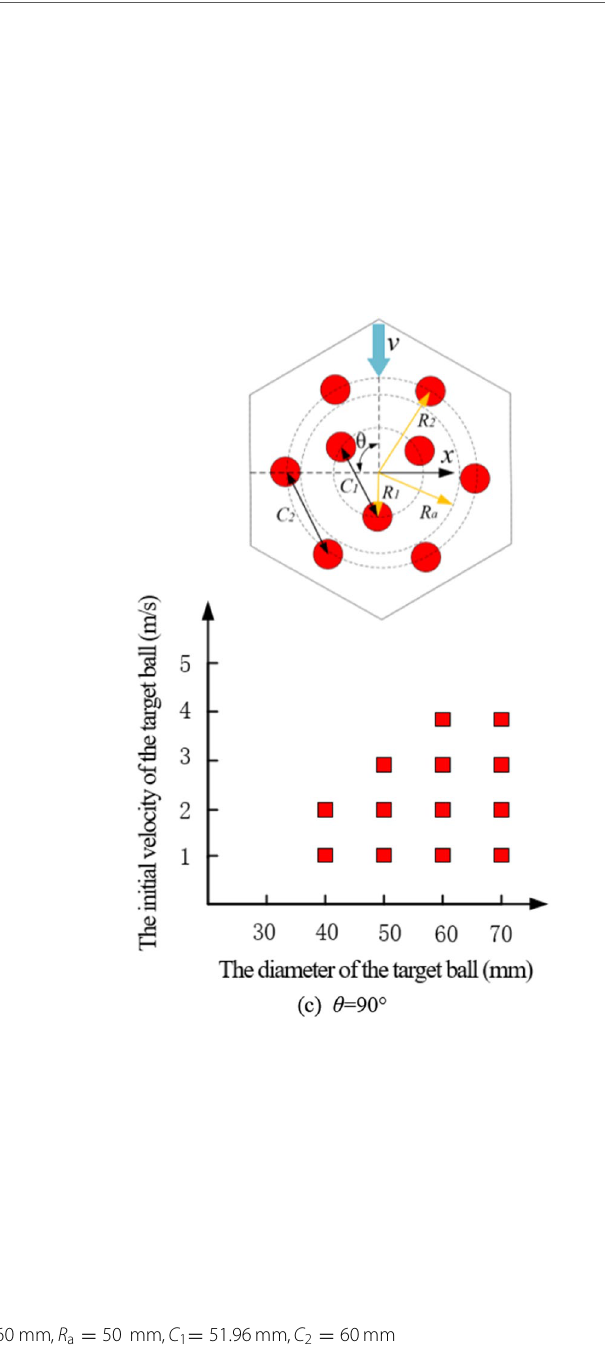
a low density of the arm group, and vice versa. The clear- ance of the arms, C , is defined as the linear distance of adjacent arms on the same distribution circle, as shown in Figures 6, 7 and 8.